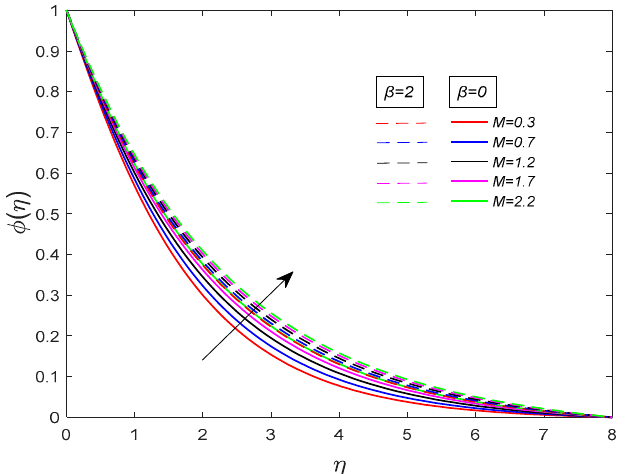
Figure 5. Effect of magnetic parameter (M) on concentration profile with Pr = Sc = 0.7, Ec = Kr = Sr = 0.1.